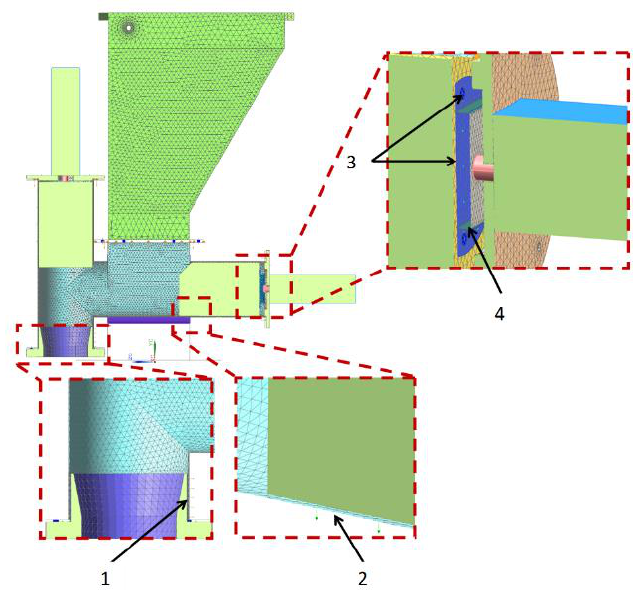
Figure 5. Calculation model of molding center with a processing tank. View 2: connection of the actuator with the pusher of the dispenser, bolted connection, contact set, piston rod, and rigid connection. 1. Contact set, 2. Contact set, 3. Bolted connection and contact set, 4. RBE2 rigid elements. The method of modeling the interconnection of the die assembly to the forming center and table is shown in Figure 6. The die assembly was able to slide over the sliding elements; therefore, the contact between these elements was modeled. The sliding elements, die assembly, and runners were modeled with 3D elements. Tetrahedral elements used in the computational model in 3D subassemblies were used to map the load transfer of mutually cooperating elements by giving them contacts both on the surface and on the side walls. The type of 3D element used was only used to evaluate the stress distribution, indicating places with the highest stress concentration and directions of displacement of elements under load.